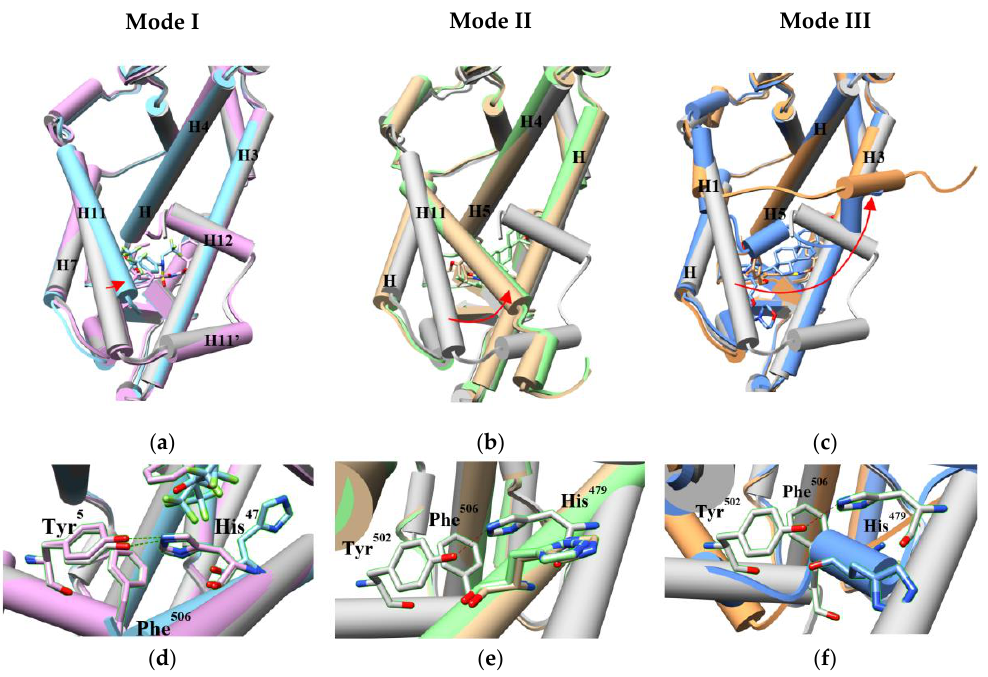
Figure 6. Three different conformation modes of the RORγ orthosteric pocket ( a – c ) and the changes of the agonist lock ( d – f ) induced by orthosteric inverse agonists. The apo LBD model is shown in grey. The H11 movement is demonstrated by red arrows. ( a , d ) Two crystal models in mode I with bound ligands are presented in cyan (PDB 4NB6) and plum (PDB 4NIE). ( b , e ) Two crystal models in mode II with bound ligands are presented in light green (PDB 5X8Q) and tan (PDB 6A22). ( c , f ) Two crystal models in mode III with bound ligands are presented in blue (PDB 5NTK) and light brown (PDB